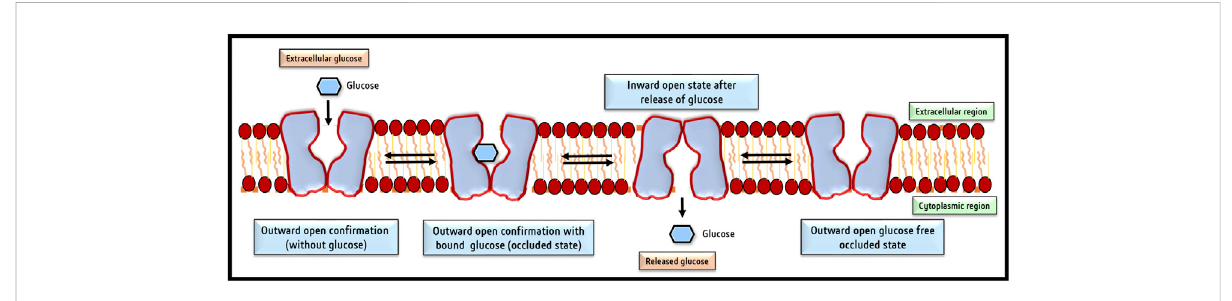
FIGURE 3 Conformational changes of GLUT facilitate glucosetransport across thecell membrane. The four conformational changes oscillatebetween1) Outsideopenconformationfacilitatingloadingofglucose;2)outwardopenconformationwithboundglucose(occludedstate);3)inwardopenstate following release of glucose and 4) shifting back to the outward open glucose-free state to capture of glucose. So basically, there are two main conformations the outside open (OOP) and inside open (IOP)